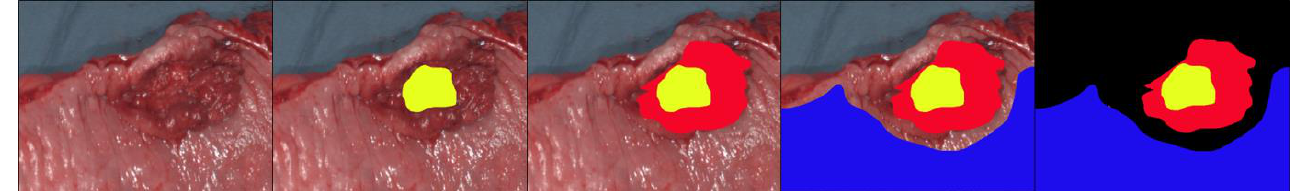
Figure 1. Annotation process. A pT3 adenocarcinoma of the sigmoid colon. The first annotation in yellow marks the certain tumor tissue; in red the surrounding tissue, probably with adenoma parts; in blue the healthy mucosa; and in black the deleted unmarked areas.